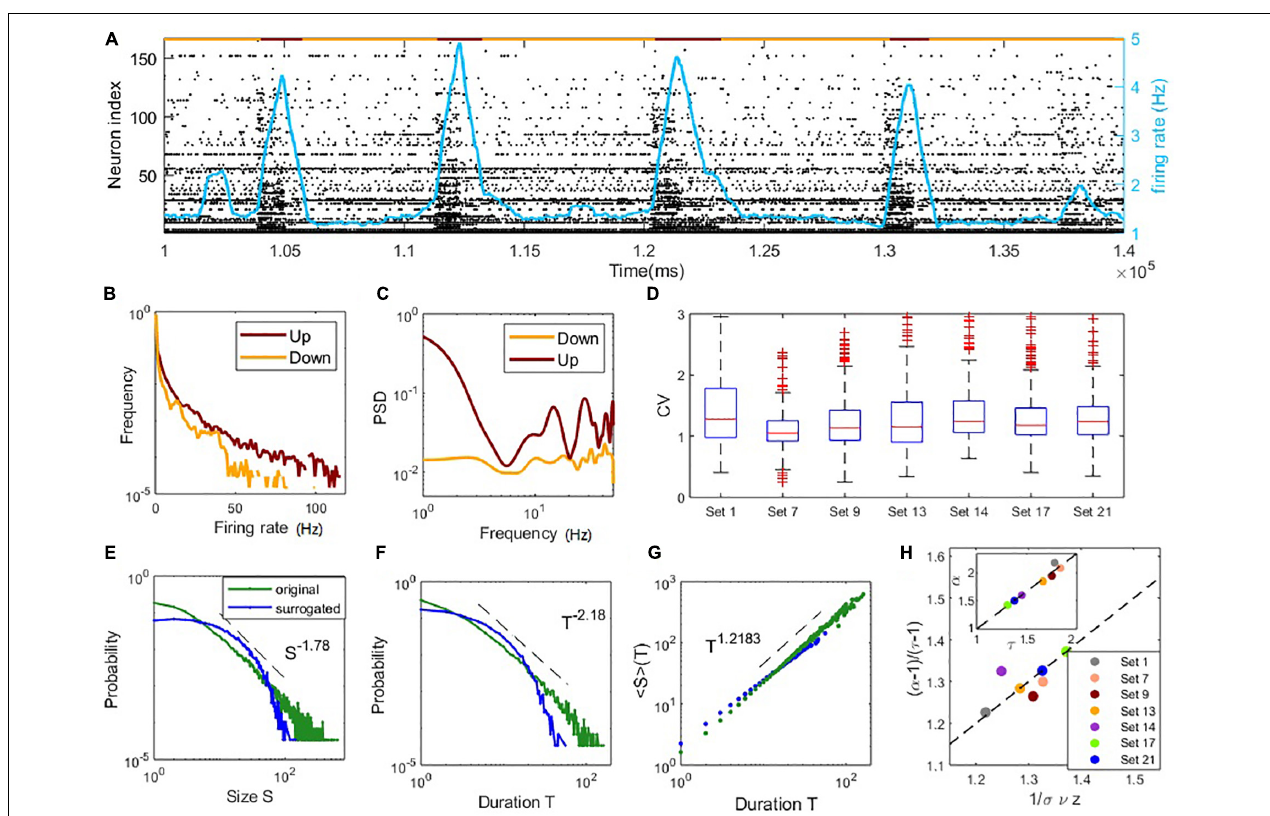
FIGURE 4 | Coexistence of irregular spiking and critical avalanches in experimental data sets. (A) The raster plot of spiking time of data Set 1 in a period. Each point corresponds to a spike of a neuron. Indexes are sorted according to the total number of spikes during the whole recoding time. The red/yellow segments in the top indicate the up/down states. (B) The distribution of the neurons firing rate in up and down states. (C) The power spectral density of the population firing rate in up and down states. In panels (B,C) , the examples are shown by an up and a down period of data Set 1. (D) Boxplots of the CV distribution across neurons in different data sets. (E–G) : critical avalanche properties of data Set 1. (E) Probability density distribution of the avalanche size. (F) Probability density distribution of the avalanche duration. (G) Mean avalanche size with respect to the given avalanche duration. The power-law distributions of size and duration are destroyed by surrogated data with shuffled ISI (denoted by blue curves). (H) Scaling relations between critical exponents of different data sets, similar to Figure 3H